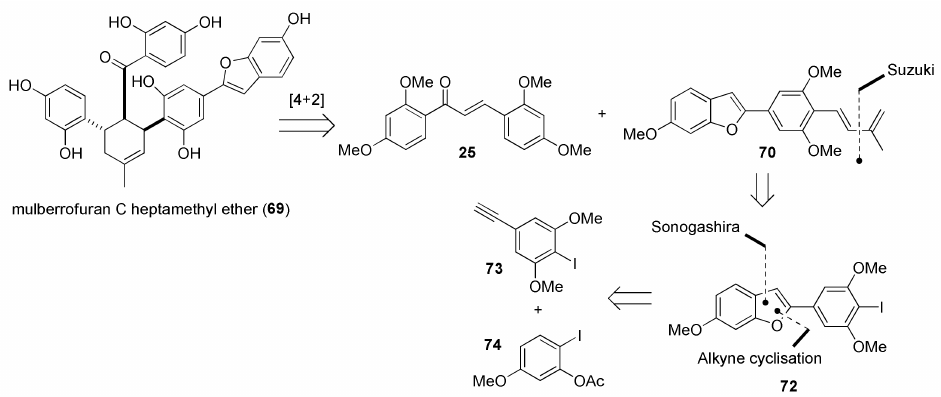
Figure 21. Retrosynthesis of mulberrofuran C heptamethyl ether ( 69 ).